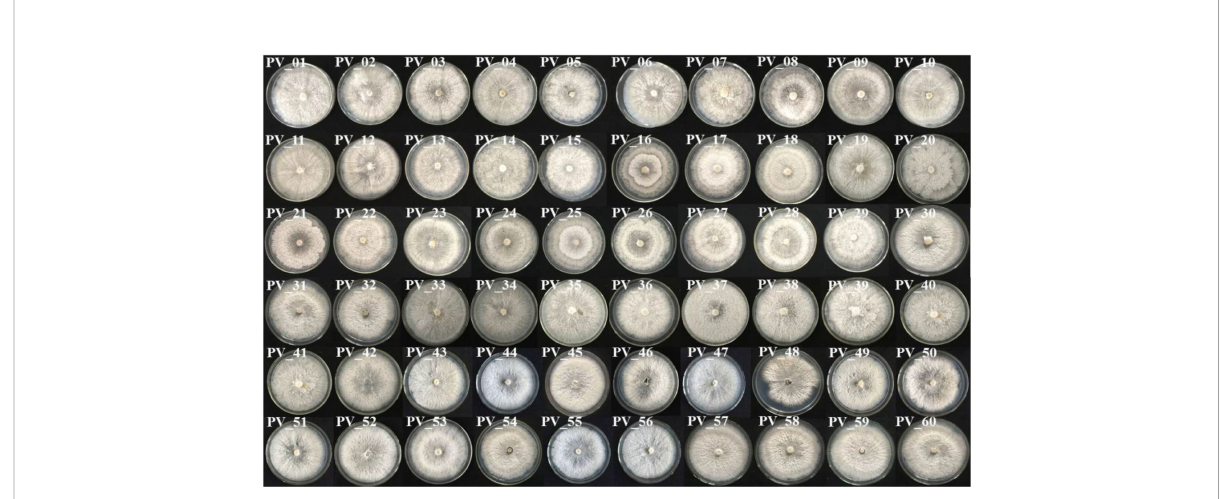
FIGURE 3 Colony morphology of P. vexans isolate strains on potato dextrose agar medium after 7 days of incubation at 25°C.